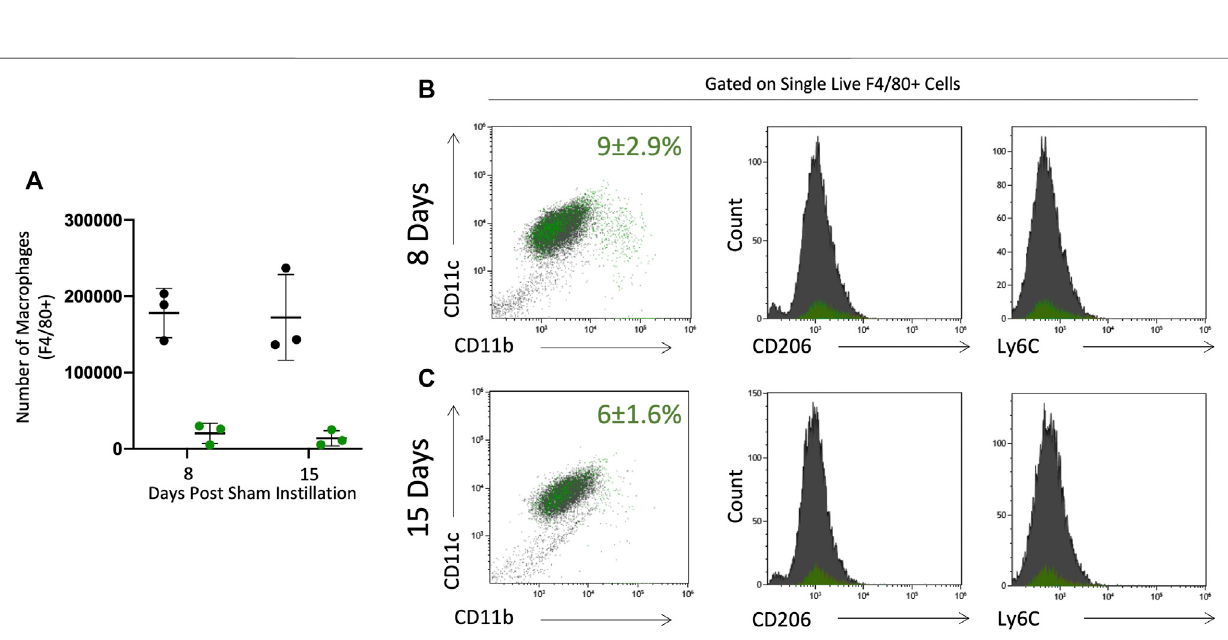
Frontiers in Pharmacology |